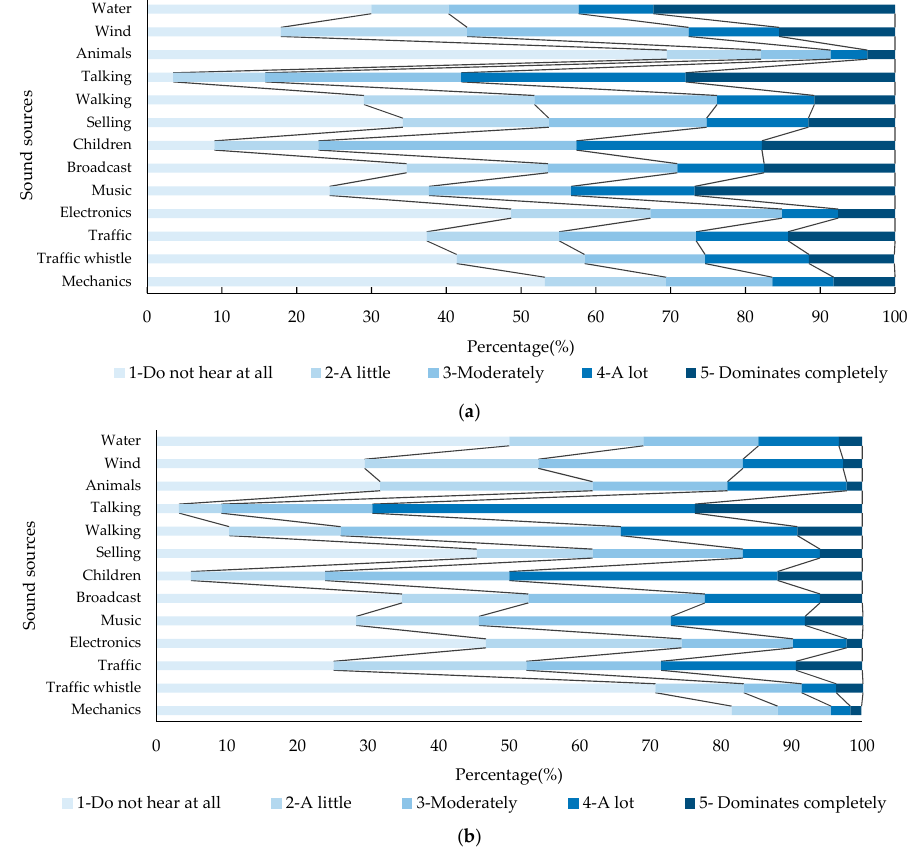
Figure 6. Sounds perception of interviewees’ perceived sources ( a ) in China and ( b ) in Croatia. Table 7. Spearman’s rho correlations of each sound source and subjective satisfaction, as well as perceived soundscape